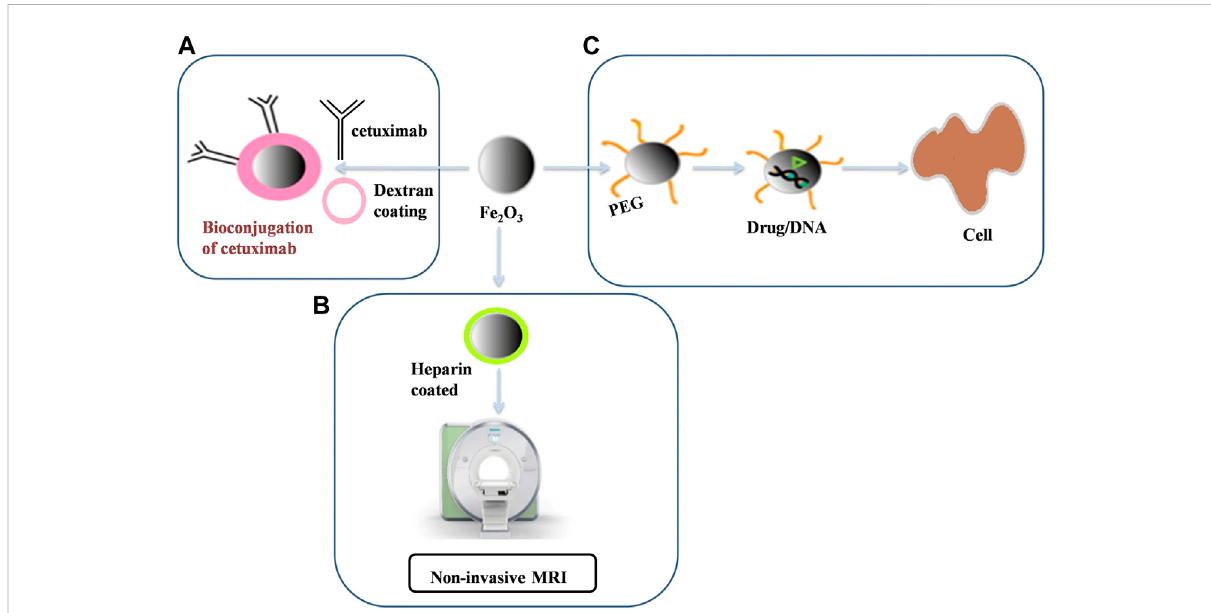
FIGURE 6 Summary of the use of iron oxide nanoparticles in (A) Conjugation of drugs like cetuximab via a PEG linker (B) Non-invasive MRIs via Heparin coated iron oxide nanoparticles and (C) Coating them with polymers like PEG for drug delivery purposes. This image was adapted from (Chenthamara et al., 2019). This image is reprinted under the terms of the Creative Commons Attribution 4.0. International